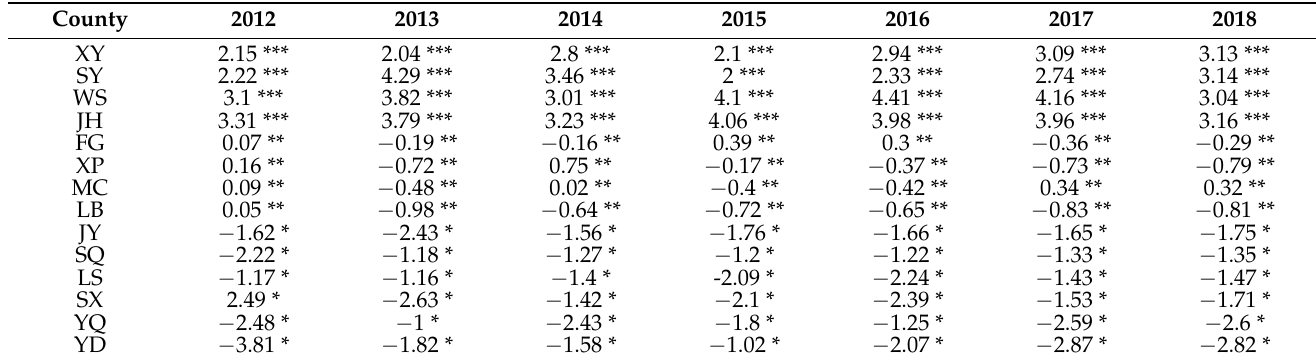
Table 2. Index of socioeconomic factors for the 14 counties in the